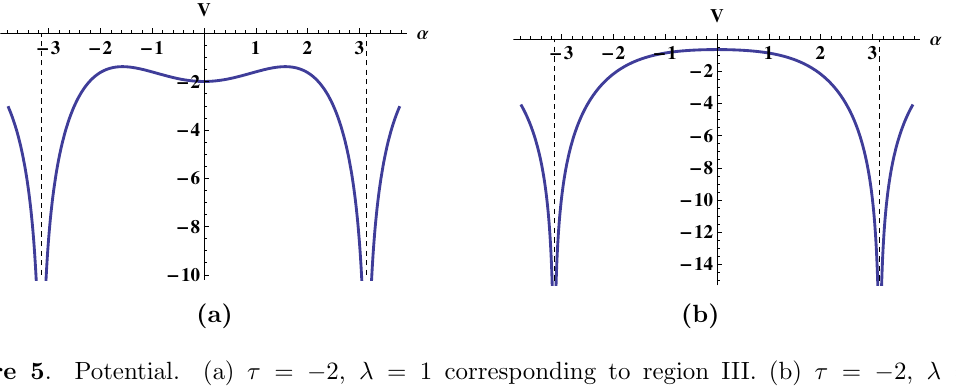
Figure 5 . Potential. (a) (cid:28) = (cid:0) 2, (cid:21) = 1 corresponding to region III. (b) (cid:28) = (cid:0) 2, (cid:21) = 3, corresponding to region